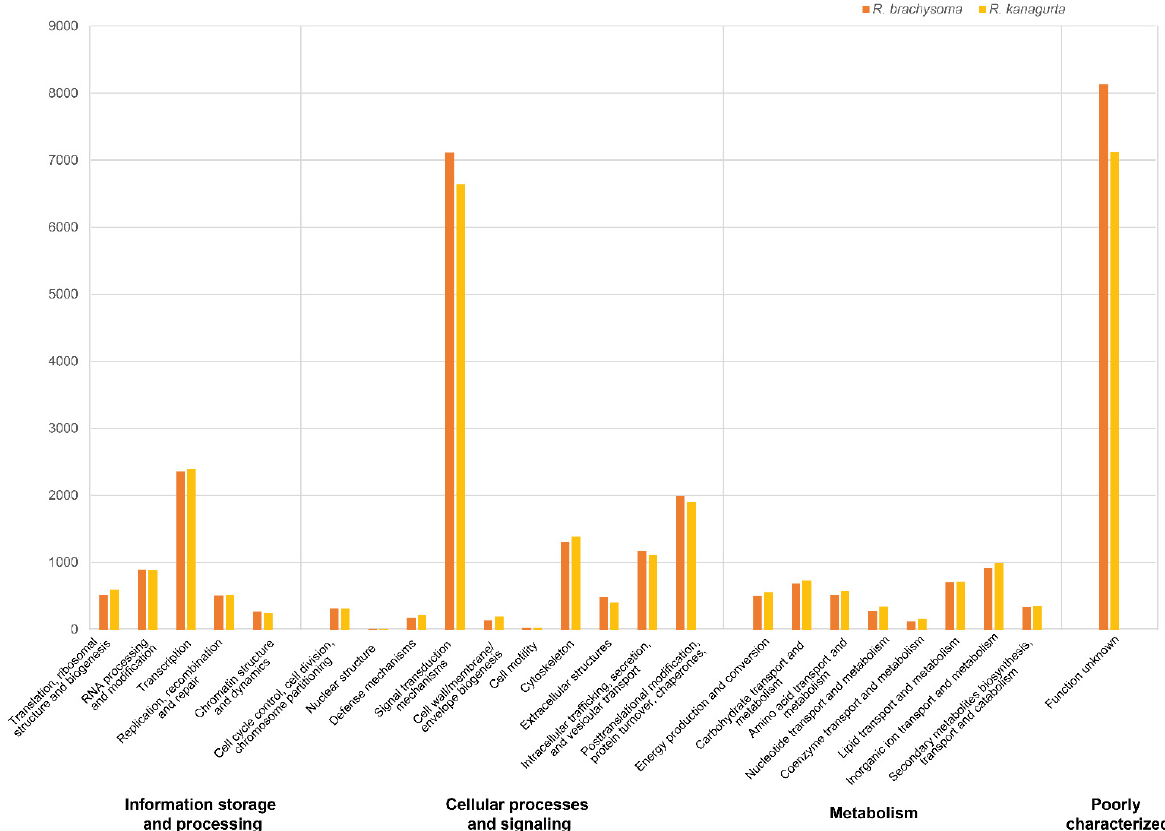
Figure 3. Functional annotation statistics for R. brachysoma and R. kanagurta .